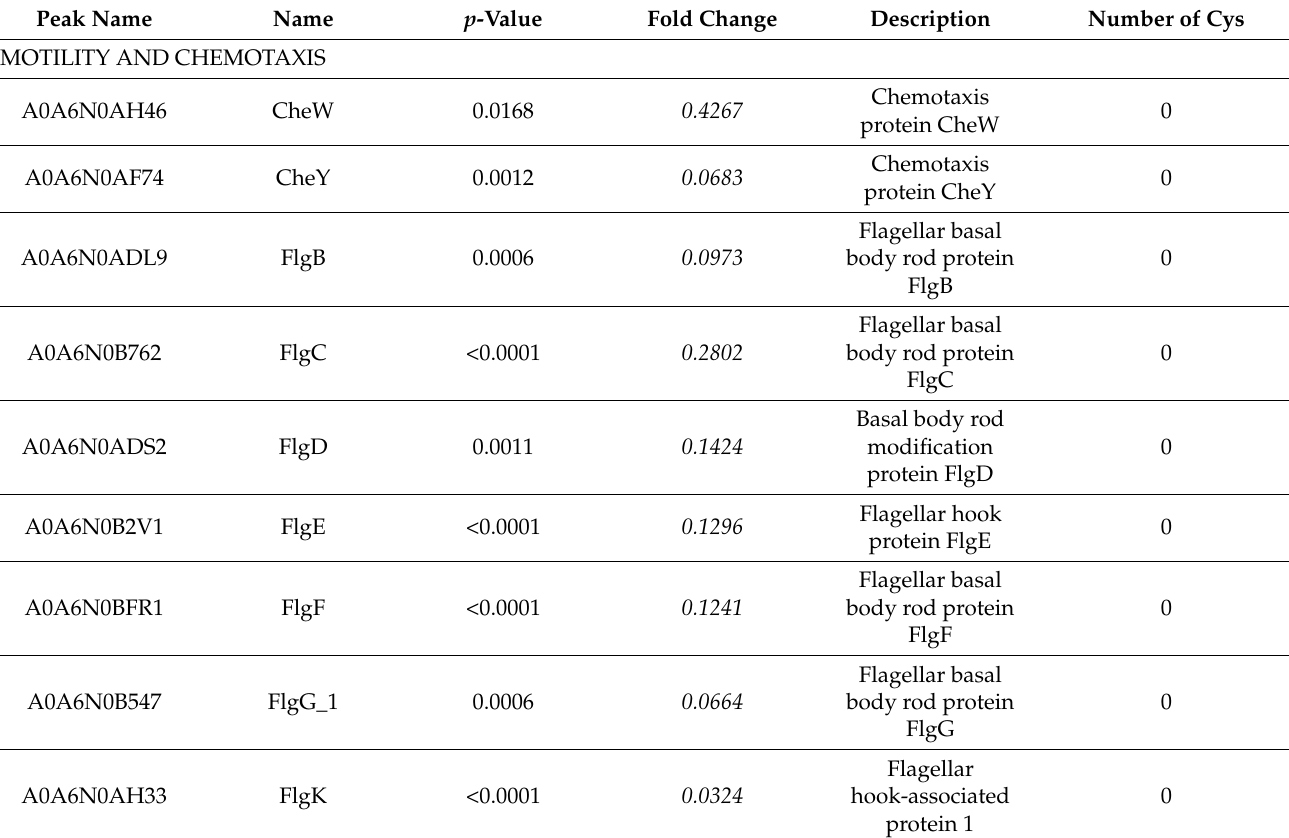
Table 3. Extracellular proteins whose level is downregulated due to the lack of a functional DsbA